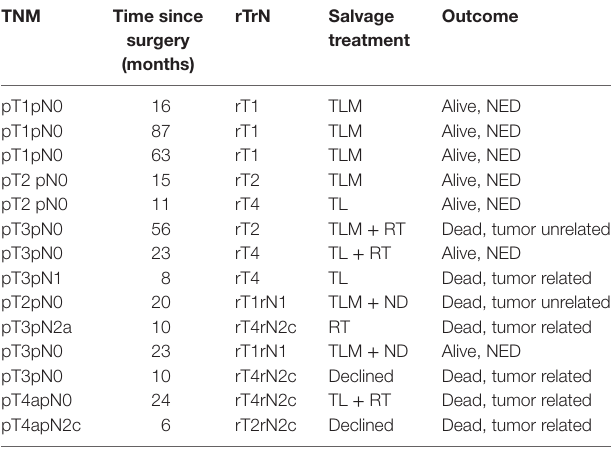
Table 3 | Analysis of local and locoregional